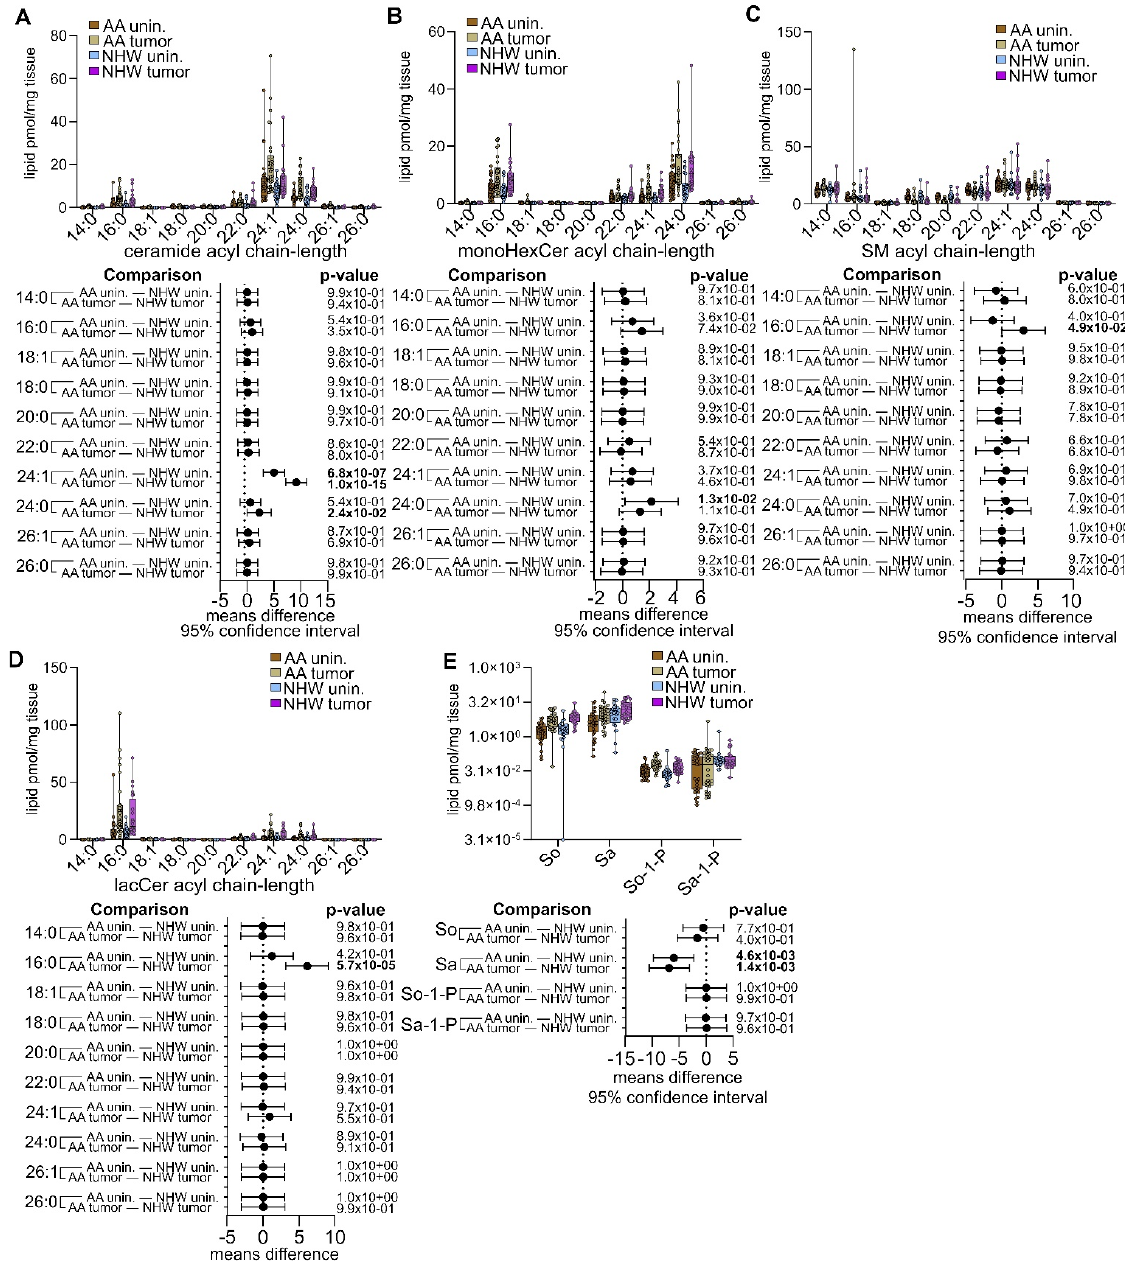
Figure 6. Secondary analysis comparisons of unin. vs. unin. and tumor vs. tumor sphingolipid profiles of self-identified AA and NHW males with COAD. Data presented in Figures 2I–L,W and 3I–L,W were analyzed to examine differences in the indicated lipids between unin. and tumor tissues of self-identified AA and NHW males with COAD. In each panel ( A – E ), the upper graphs are box plots showing medians (black line) and whiskers of min to max (top), and the bottom graphs are plots of the 95% family-wise significance and confidence intervals for predicted means difference